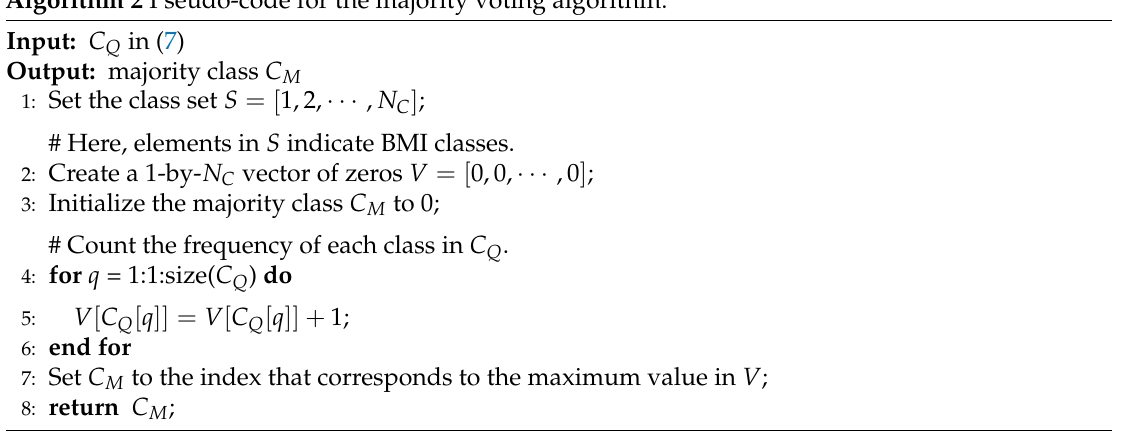
Algorithm 2 Pseudo-code for the majority voting